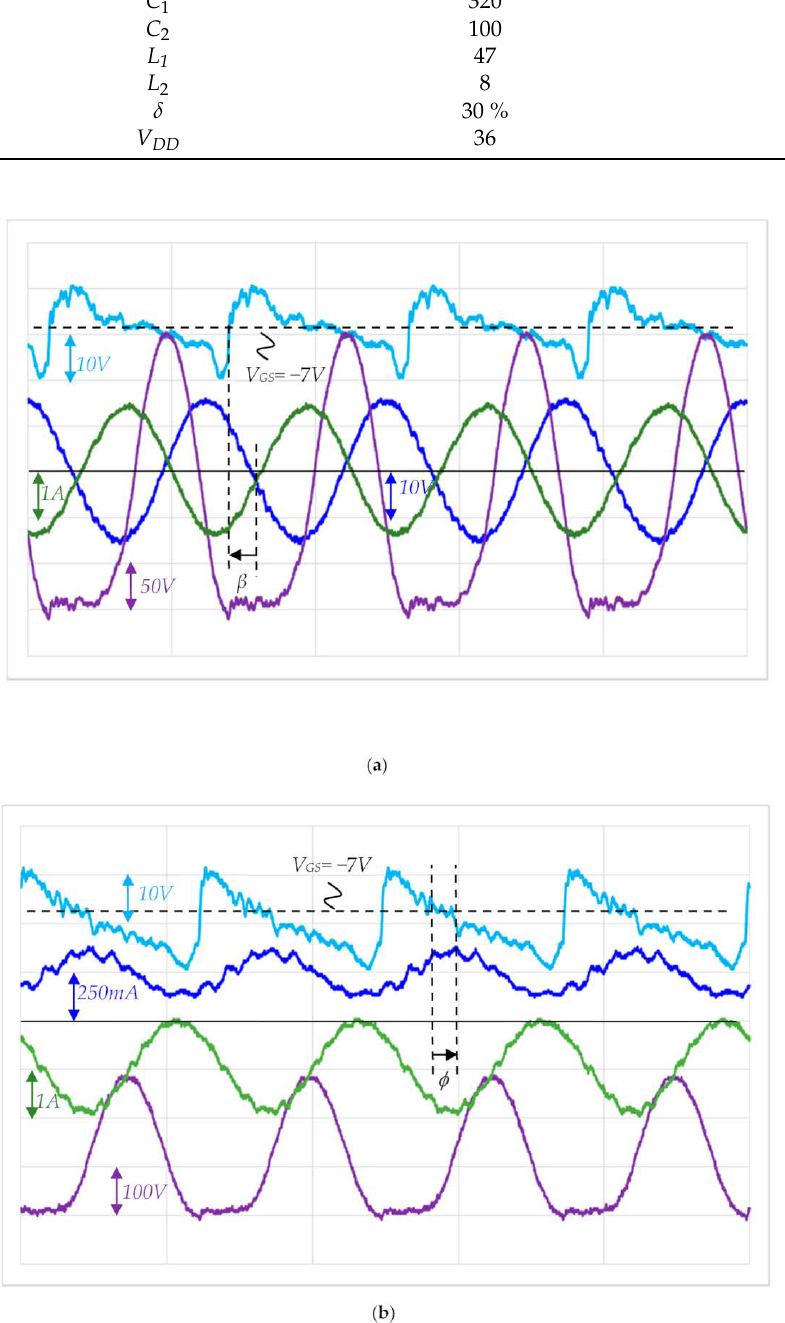
Figure 10. ( a ) Oscilloscope screen dump showing i 2,PRU (green curve), v DS (purple curve), v R,PRU (blue curve), and v gs (cyan curve). ( b ) Oscilloscope screen dump showing i D,PRU (green curve), i 1 (blue curve), and v gs (cyan